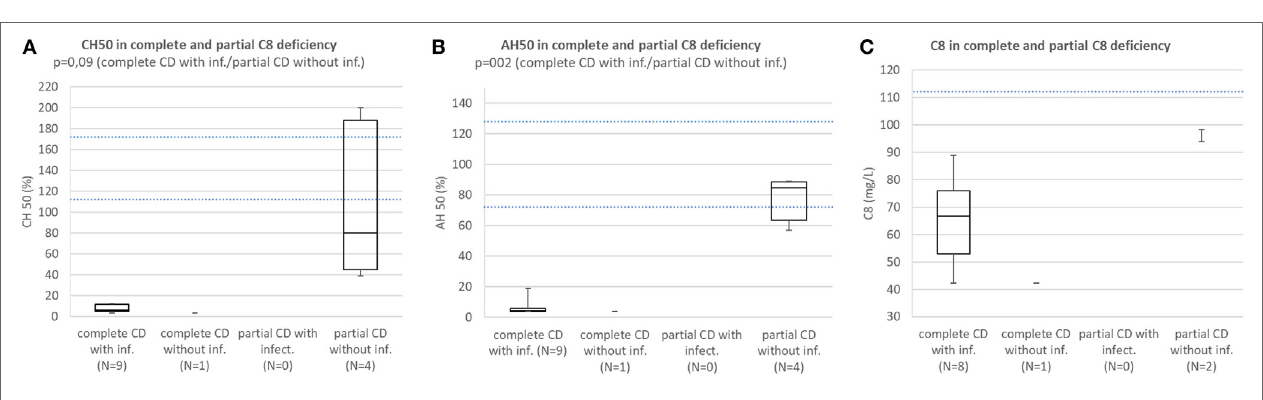
FigUre 5 | (a) Comparison of CH50 between patients with complete C8 deficiency with infections, complete C8 deficiency without infections, patients with partial C8 deficiency with infections, and subjects with partial CS deficiency without infection. (B) Comparison of AH50 between patients with complete C8 deficiency with infections, complete C8 deficiency without infections, patients with partial C8 deficiency with infections, and subjects with partial C8 deficiency without infection. (c) Comparison of C8 concentration between patients with complete C8 deficiency with infections, complete C8 deficiency without infections, patients with partial C8 deficiency with infections, and subjects with partial CS deficiency without